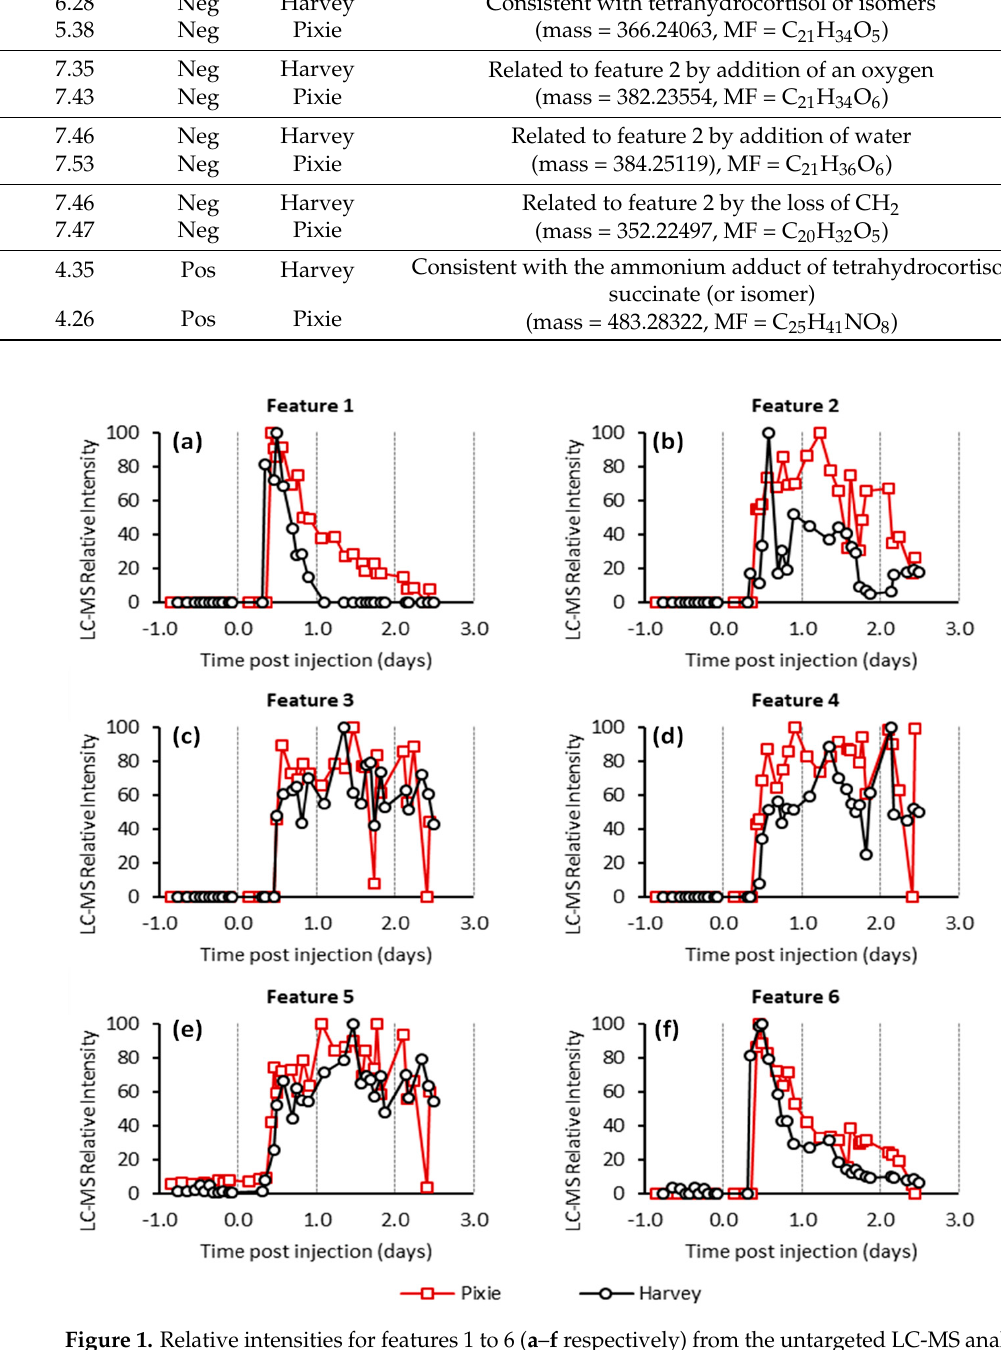
Figure 1. Relative intensities for features 1 to 6 ( a – f respectively) from the untargeted LC-MS analysis. The intensities scaled to the most abundant measurement within the series.